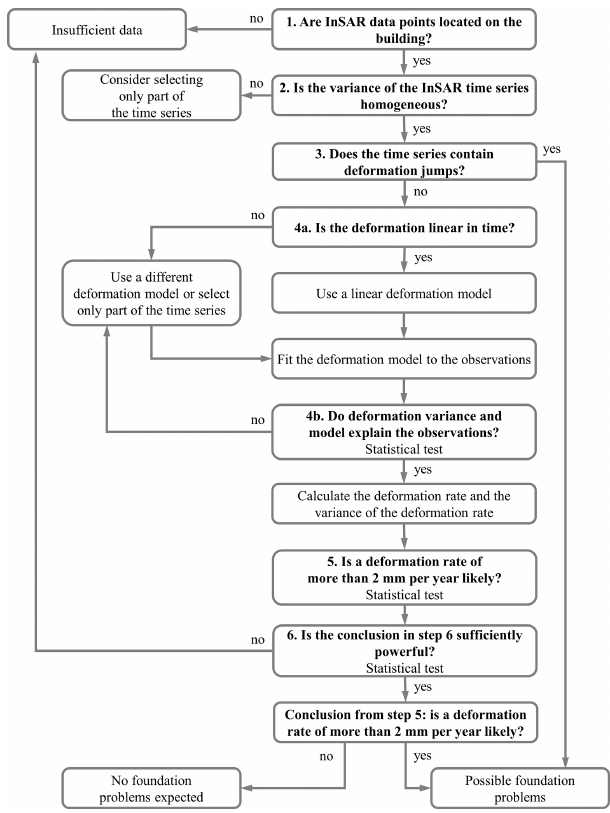
Figure 3. Flow chart showing main steps of the procedure to deter- mine the measurement